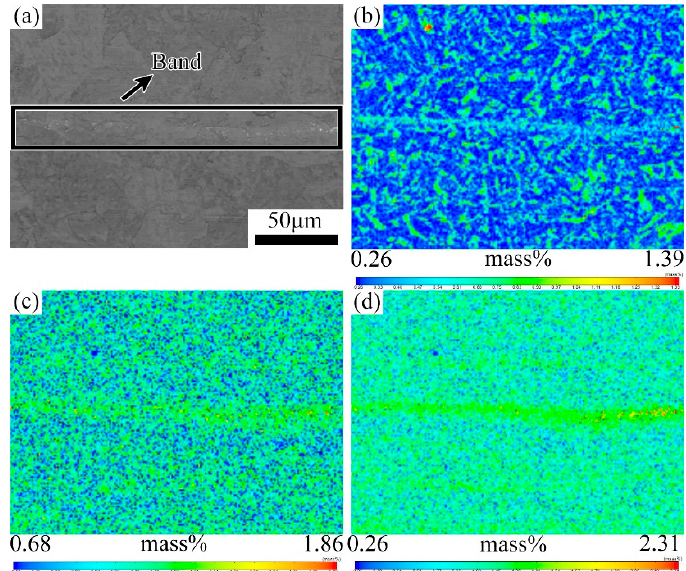
Figure 4. Lower ( a ) and higher ( b ) magnified scanning electron microscopy (SEM) image of banded structure in hot rolled sample. (A-austenite, B-bainite F-ferrite and P-pearlite).